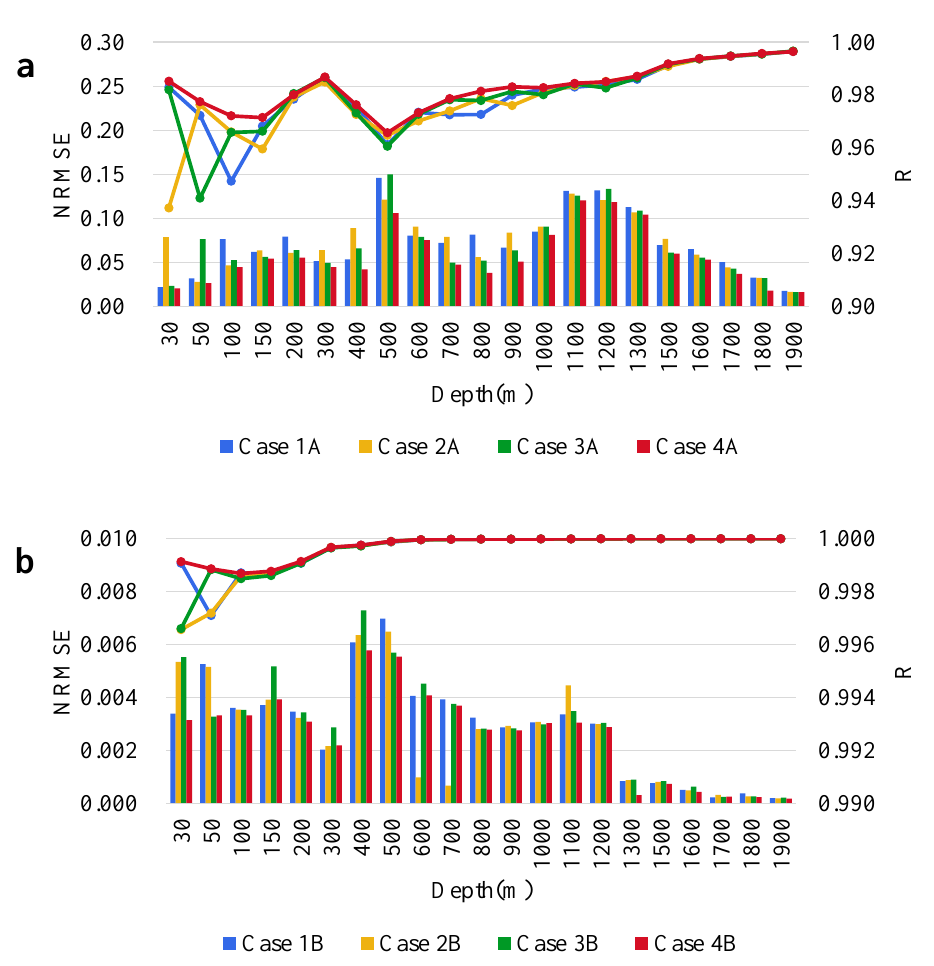
Figure 3. The NRMSE (left, bar) and R (right line) of inversion results at different depths by ConvL- STM models in different cases: ( a ) ST, ( b )